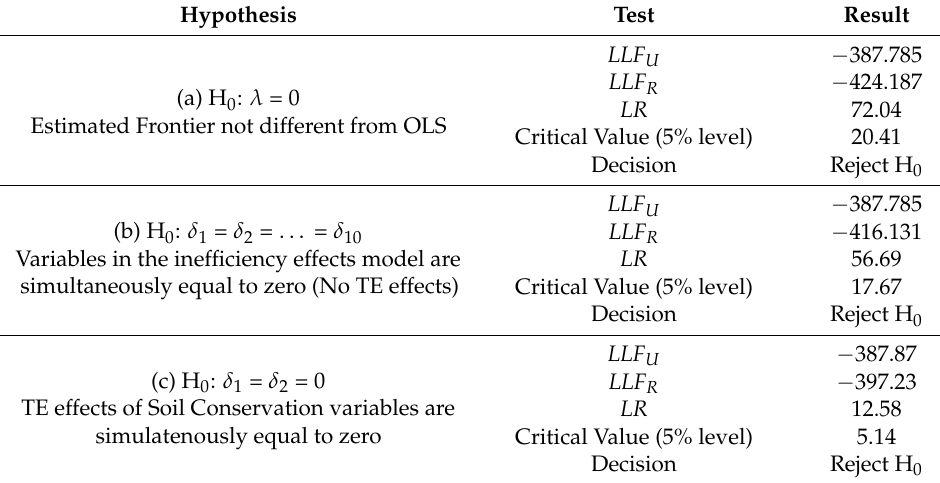
Table 4. Likelihood ratio tests for the hypotheses of inefficiency effects